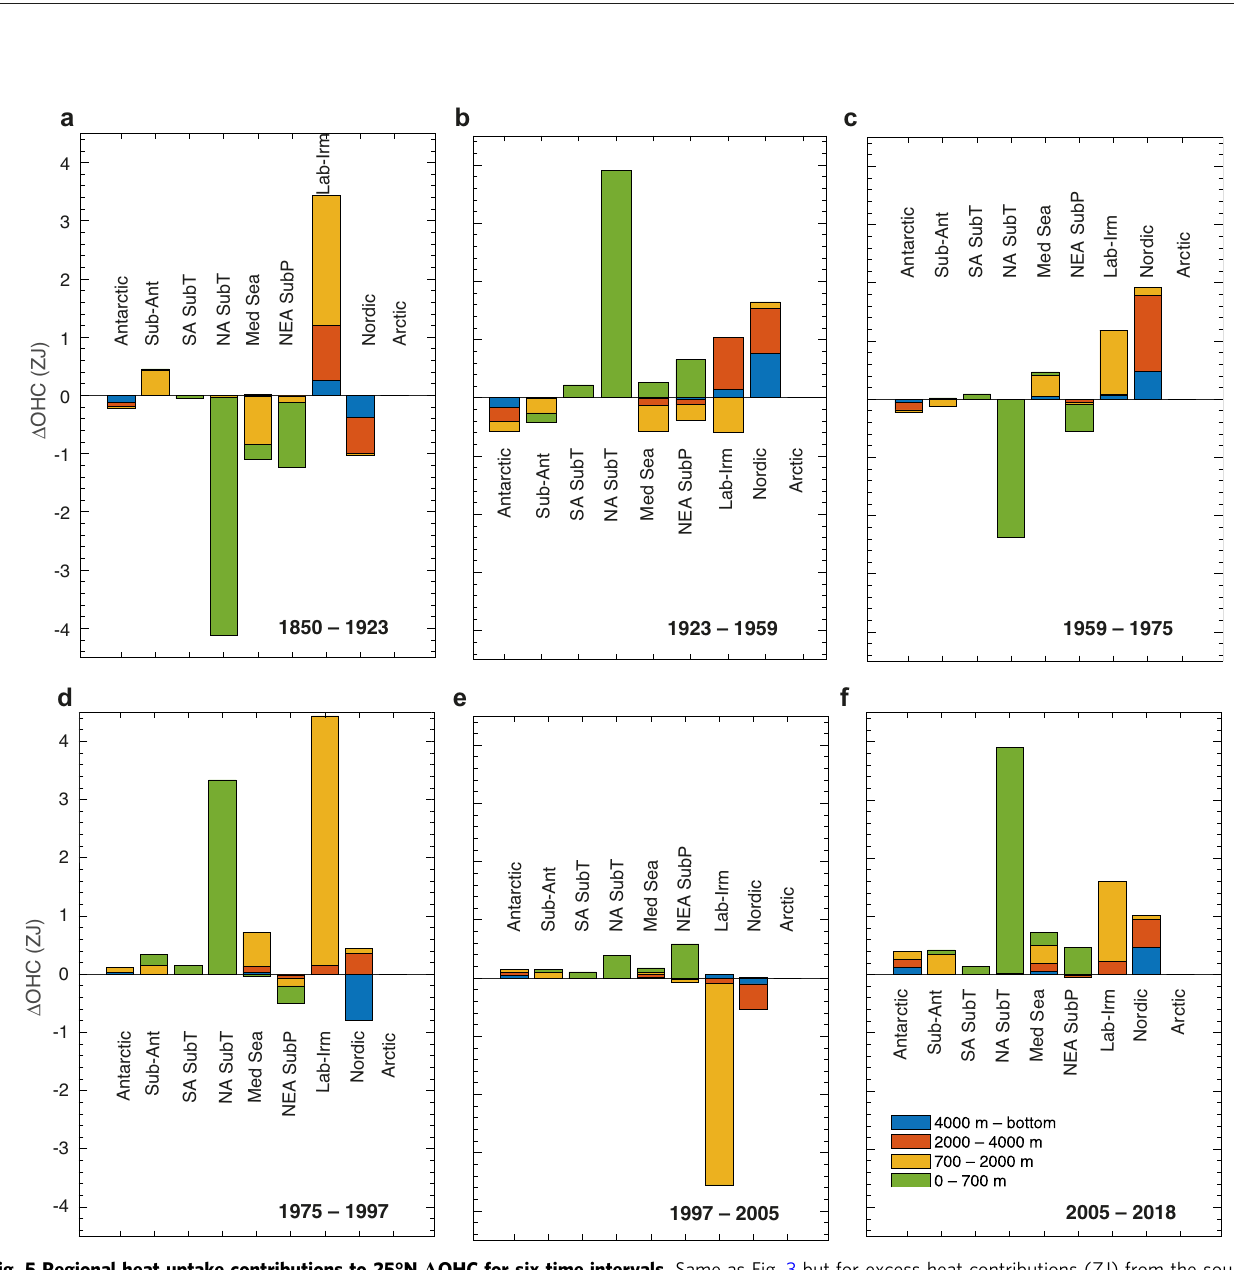
Fig. 4 Historical contributions of the North Atlantic source regions to full water column Δ OHC at 25°N and their future projections. a Time series of NAO index 45 . b Times series of the Δ SST (blue, right y -axis) and of the full depth Δ OHC response at 25°N (black, left y -axis), both relative to 1850, for the NEA SubP source region de fi ned in Fig. 3a. The Δ OHC is extrapolated in latitude over 10 degrees as in Fig. 2. The Δ SST are regionally averaged over 5° × 5° patches, each patch being weighted by its contribution to the full water column at 25°N. The Δ SST are low-passed fi ltered using a 10-year moving mean. The Δ SST time axis is shifted backward in time by the modal age to highlight the correspondence between Δ SST and Δ OHC. The Green ’ s functions potential to infer the interior signal from past Δ SST is also used to project Δ OHC in the future over a time span equal to the modal age (yellow dotted line). The grey shading represents the one standard deviation of the time series estimated as in Fig. 2. c – f . Same as for ( b ) but for Lab-Irm, Nordic, NA SubT, Med-Sea. Note the different y -axis scales. The six climatic epochs identi fi ed in Fig. 2a are indicated by numbers as follows: 1 . Late-nineteenth-century cooling (1879 – 1919), 2 . Early-twentieth-century warming (1923 – 1943), 3 . Mid-twentieth-century cooling, (1943 – 1970), 4 . Late-twentieth-century warming (1975 – 2007), 5 . Early-twenty- fi rst-century slowdown (2007 – 2012), and 6 . Early-twenty- fi rst-century acceleration (2012 – 2018). Horizontal bars indicate NAO + (orange), NAO − (blue) when it lasted for more than 5 consecutive years, and cooling (black) and warming (white) corresponding to the six climatic epochs.